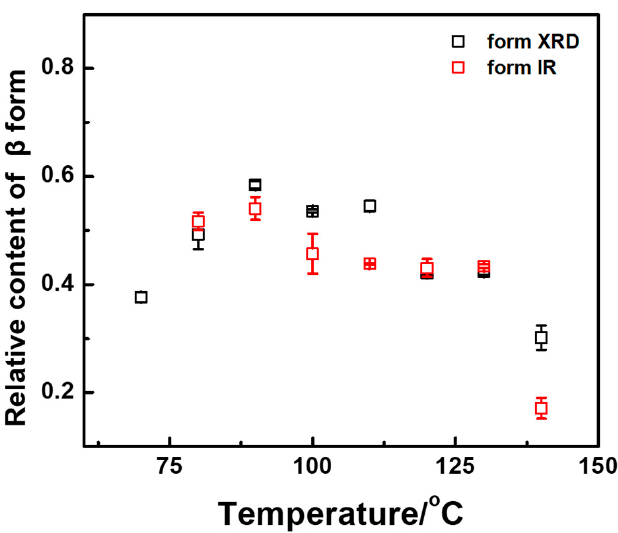
Figure 5. Comparison of relative content of β -forms versus friction transfer temperature extracted from 1D-WAXD profiles and FTIR spectra, respectively.